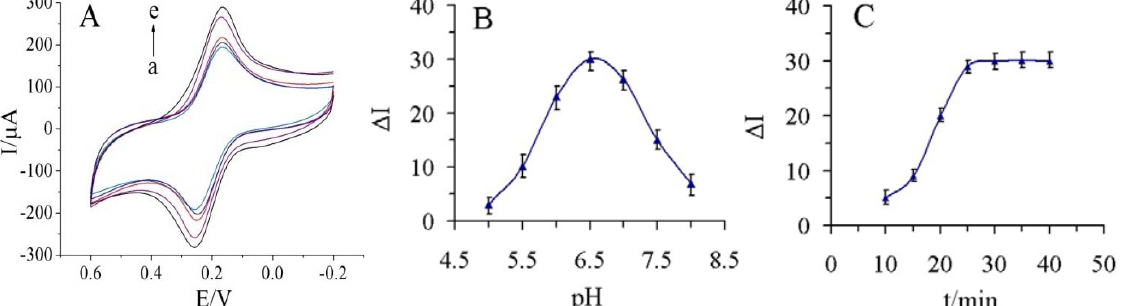
Figure 5. Effect of the thickness of the GS-PEI-Au layer ( A ) (from a to e: 2 μ L, 4 μ L, 6 μ L, 8 μ L, 10 μ L), the pH of the detection solution ( B ) and the incubation time ( C ) on the immunosensor response in 5.0 mM [Fe(CN) ] 3-/4- (pH 7.0) containing 0.1 M KCl. 6